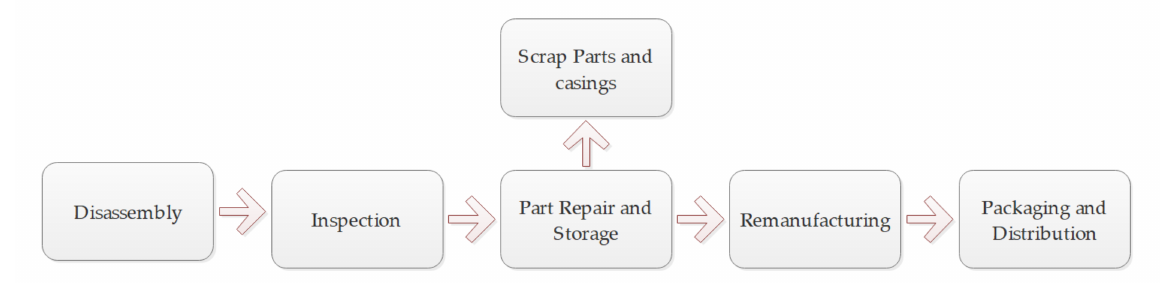
Figure 4. Remanufacturing process of